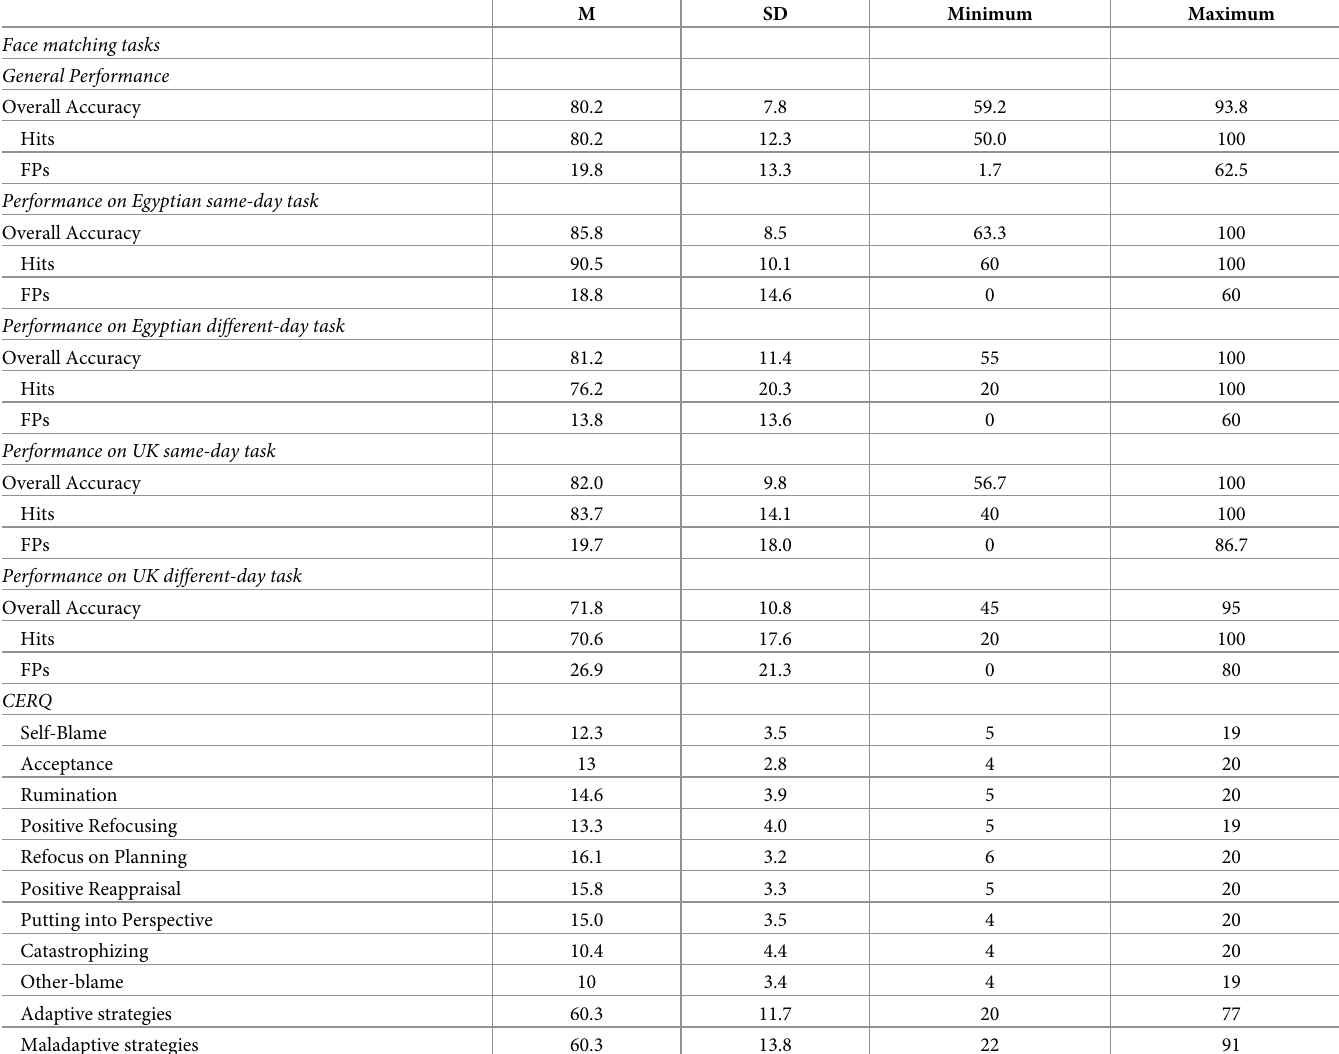
Table 6. Descriptive statistics for participants’ responses on the face matching tasks and CERQ in Experiment